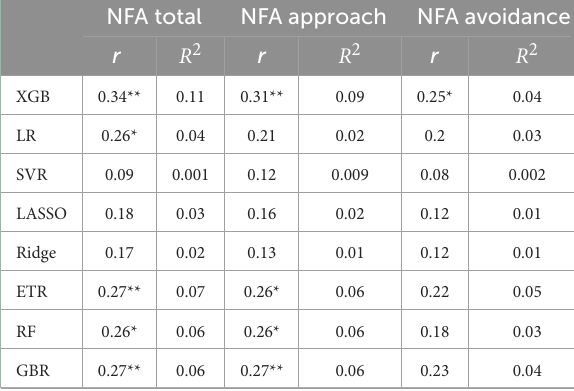
TABLE 5 The performance of models.